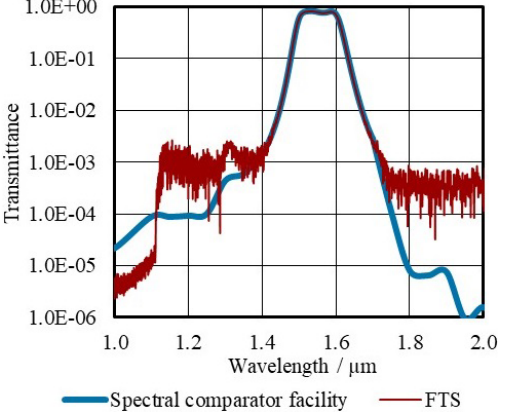
Figure 6. Transmittance of a filter with its central bandpass wave- length at 1.55µm measured with the Fourier transform spectrometer (FTS, red) and the spectral comparator facility (blue).